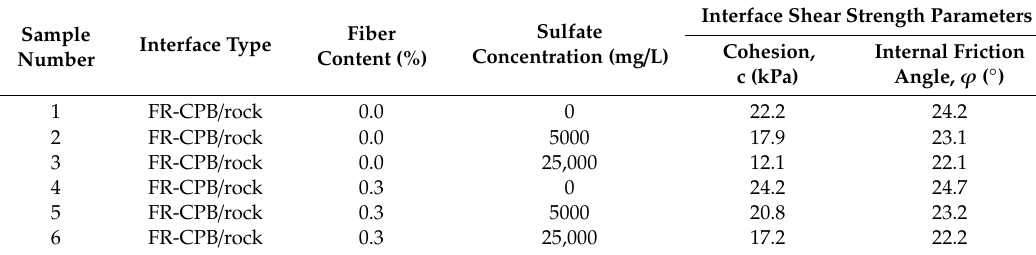
0.3% fibers. Table 5. Shear strength parameters of 1-day old interface